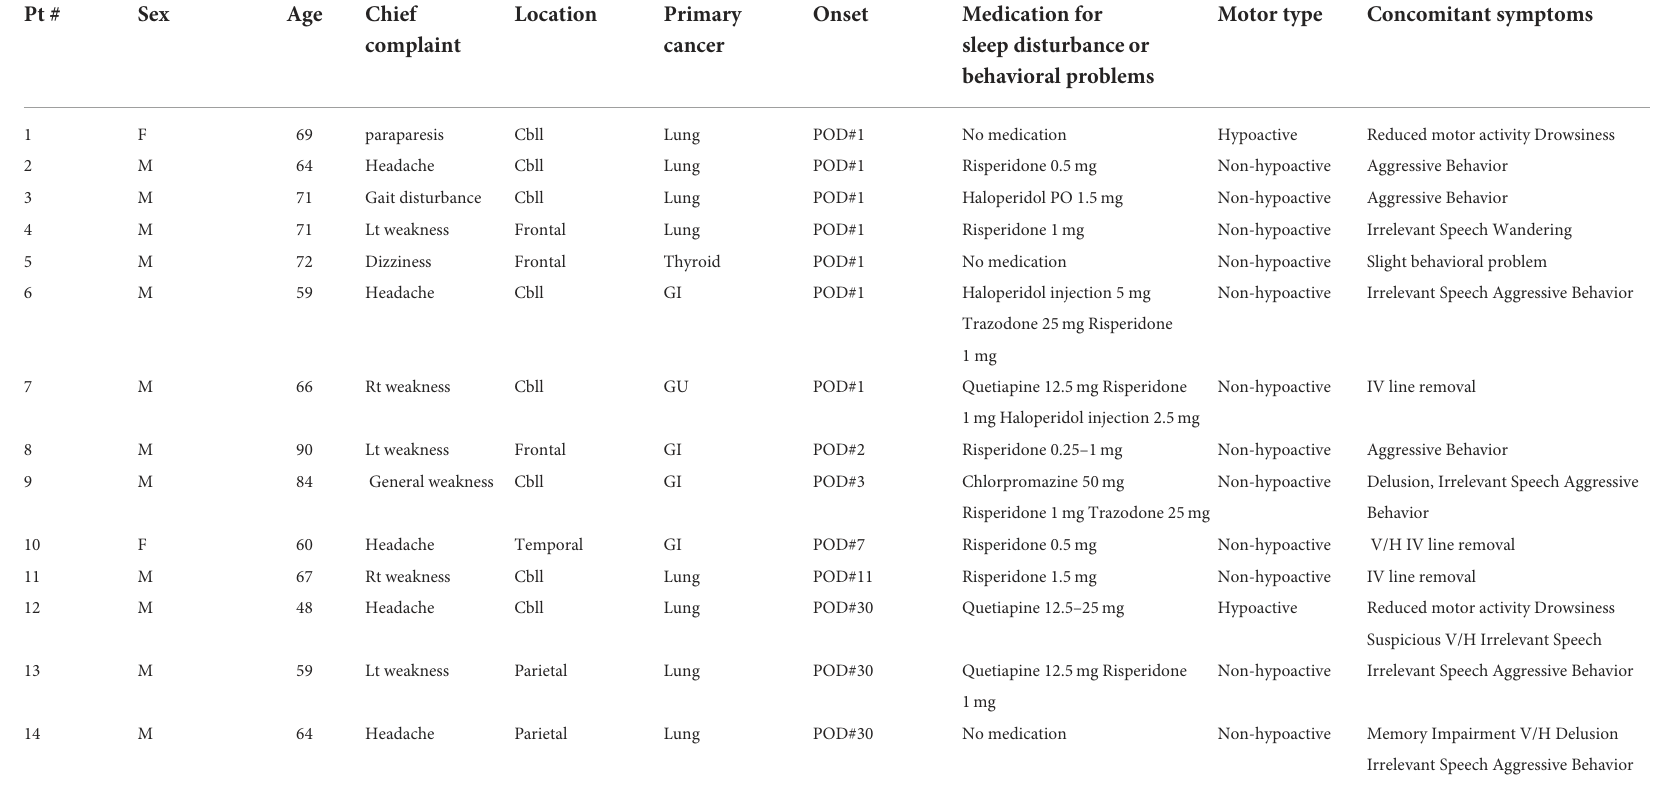
TABLE 3 Clinical features and treatment in patients with